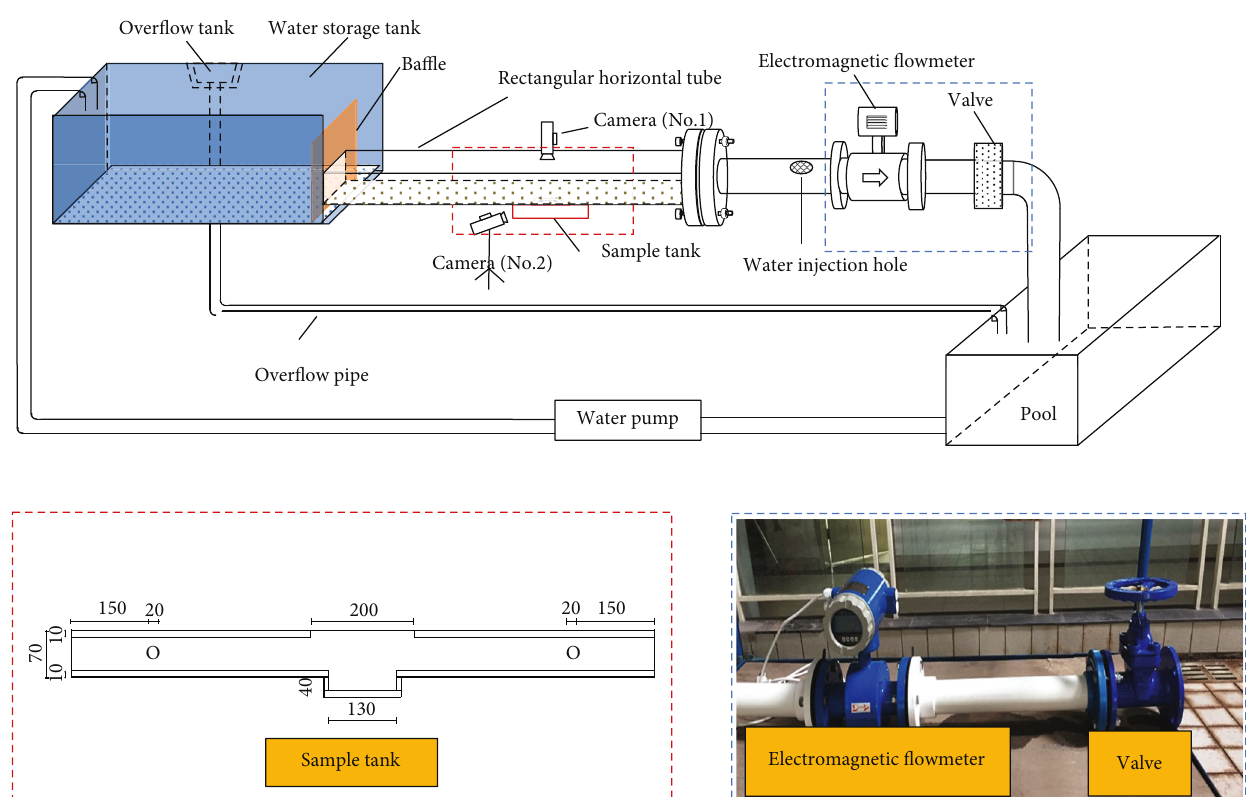
Figure 7: Reinforced tailings preset in the sample tank of the sediment incipient motion test system.